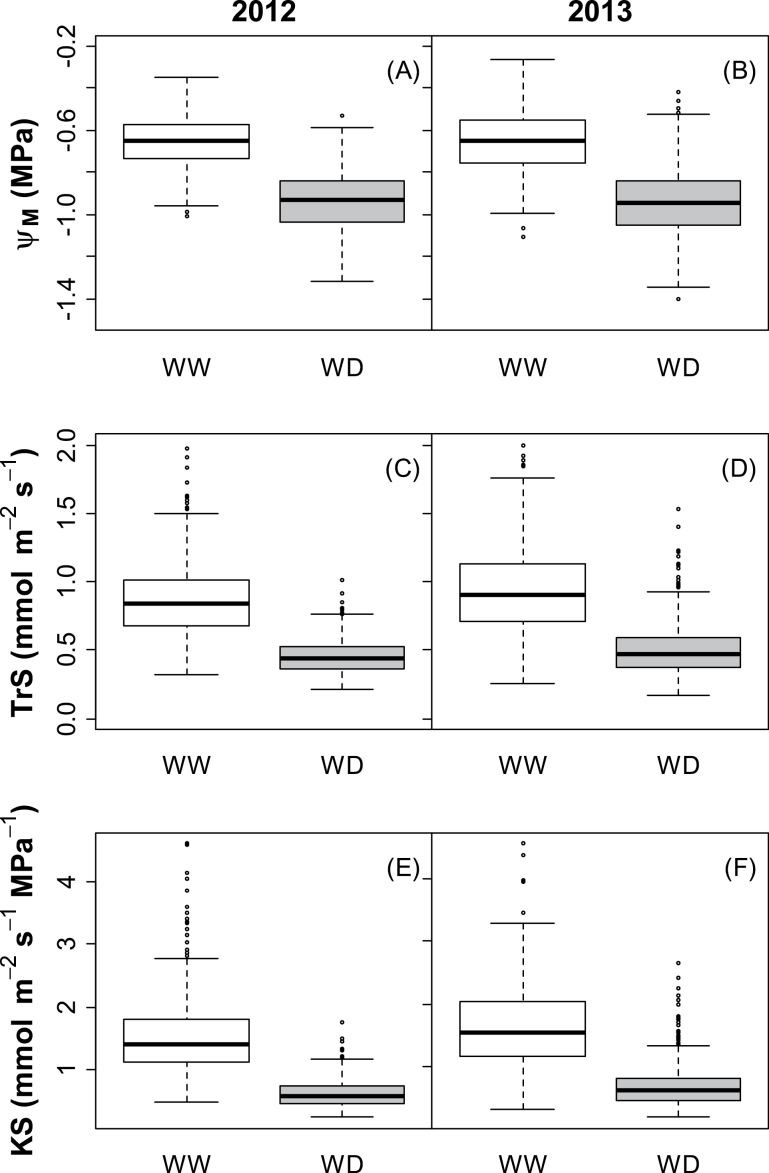
Boxplots of hydraulic traits measured on each plant of the Syrah×Grenache mapping population in 2012 (A, C, E) and 2013 (B, D, F), under well-watered (WW, white boxes) and water deficit (WD, grey boxes) treatments. See Table 1 for abbreviations (n=564 in all conditions except WW in 2012, where n=376).